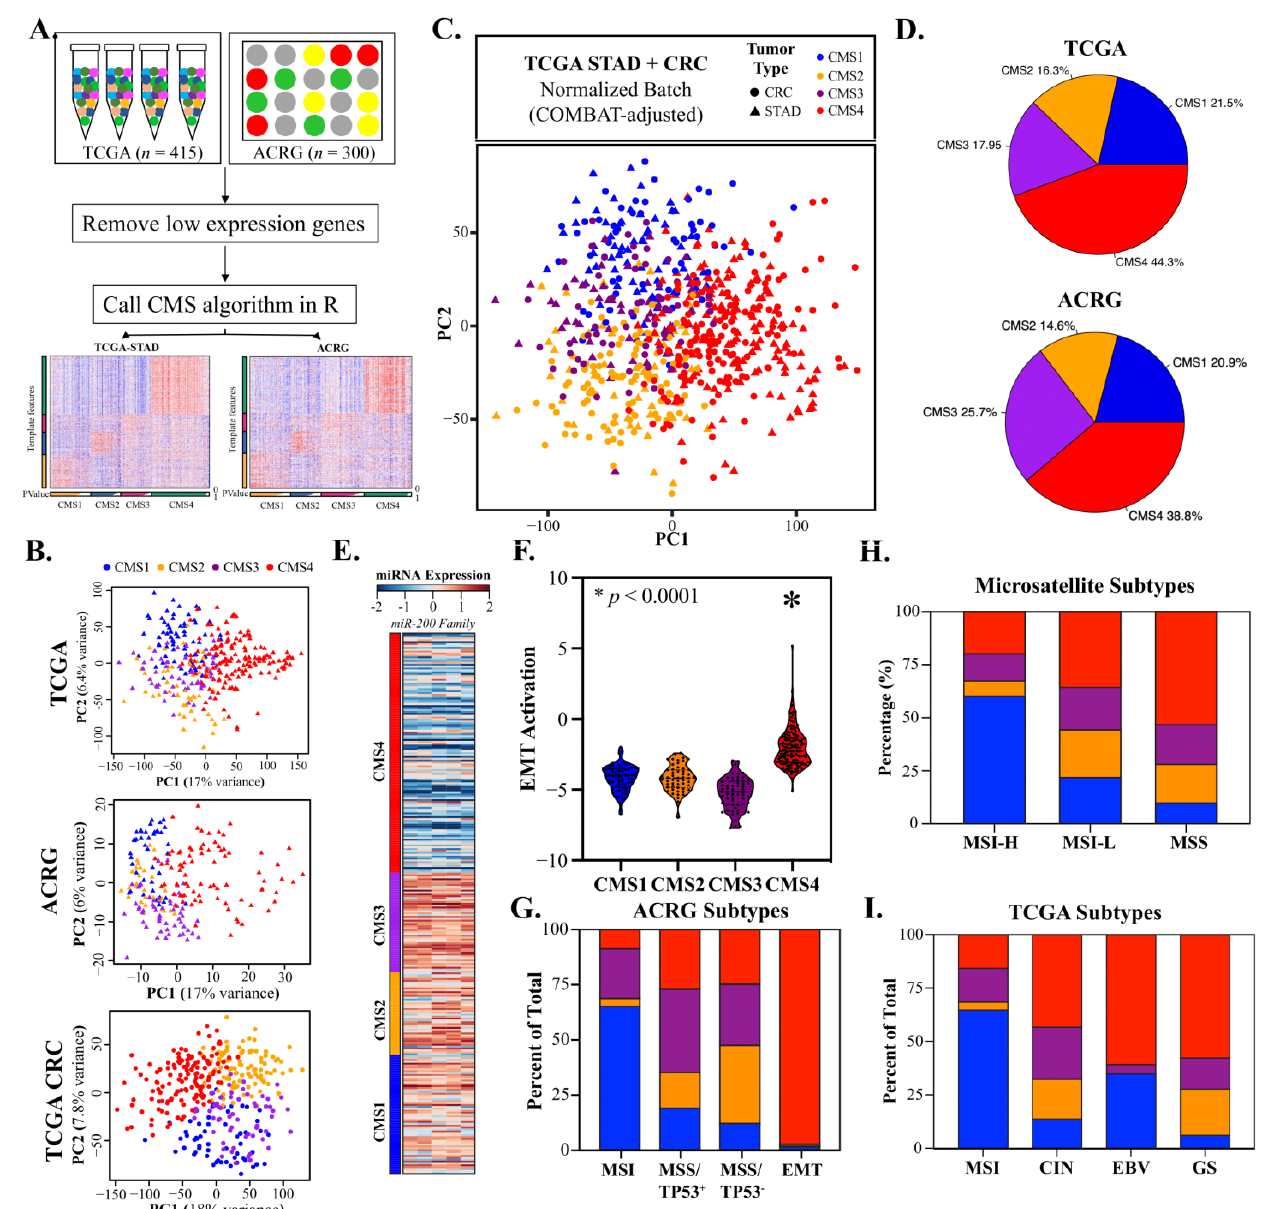
Figure 2. Consensus molecular subtypes (CMSs) can effectively classify gastric adenocarcinomas (GACs). ( A ). GAC RNA-Seq count data were downloaded from the TCGA (STAD; n = 415) and ACRG (n = 300) projects, filtered to exclude low-expression genes, and used to call CMS subtypes. ( B ). Principal component analysis (PCA) demonstrated that GAC could be divided into discrete groups based on CMS subtypes comparable to CRC (n = 380). ( C ). Application of batch correction to the TCGA GAC and CRC datasets using SVA followed by PCA showed homogeneity between GAC and CRC CMS classifications. ( D ). CMS4 is the most common classifier in GAC, followed by CMS1, CMS3, and CMS2. ( E , F ). CMS4 is strongly associated with downregulation of the miR-200 EMT inhibitor family and consequent activation of EMT. ( G – I ). CMS classifications demonstrate meaningful overlap but are distinct from current GAC classifications. Notably, CMS4 has strong contingency with the ACRG EMT subtype, and CMS1 has strong contingency for the microsatellite instable subtypes in all three systems.